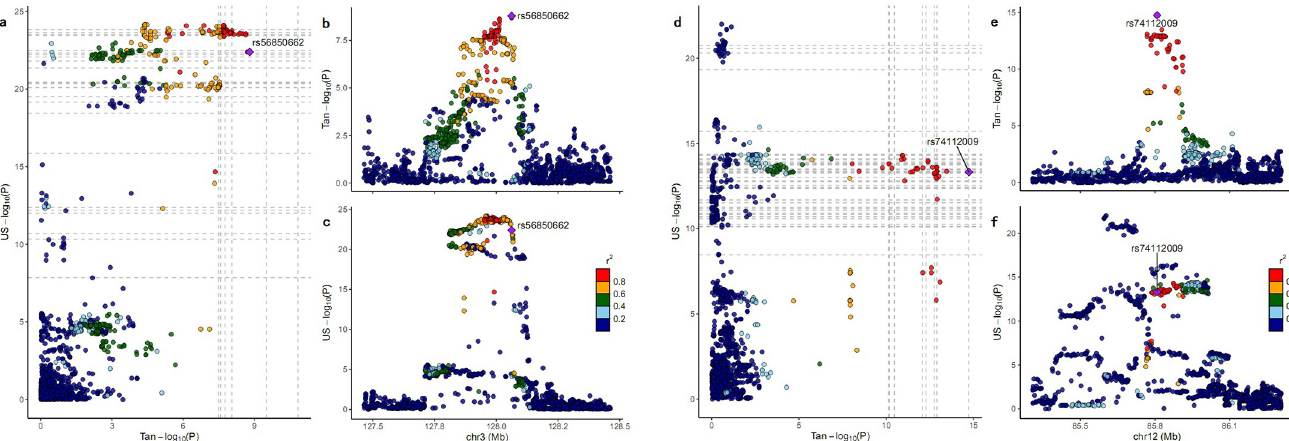
Fig 4. LocusCompare visualizations of colocalization between Tanzania GWAS and European GWAS at (a-c) 3q21.3 and (d-f) 12q21.31. The top right plots (b and e) show the association results in the Tanzania GWAS; the bottom right plots (c and f) represent the corresponding results in the European GWAS; the left plots (a and d) are visualizations of colocalization. For each locus, the SNP indicated by the purple diamond is the SNP for which the LD information is shown, with African LD structure indicated in the colocalization plot. The vertical gray dashed lines indicate the p-values of SNPs from the Tanzania GWAS that were unavailable in the European GWAS; the horizontal gray dashed lines indicate the p-values of SNPs from the European GWAS that were unavailable in in the Tanzanian GWAS.